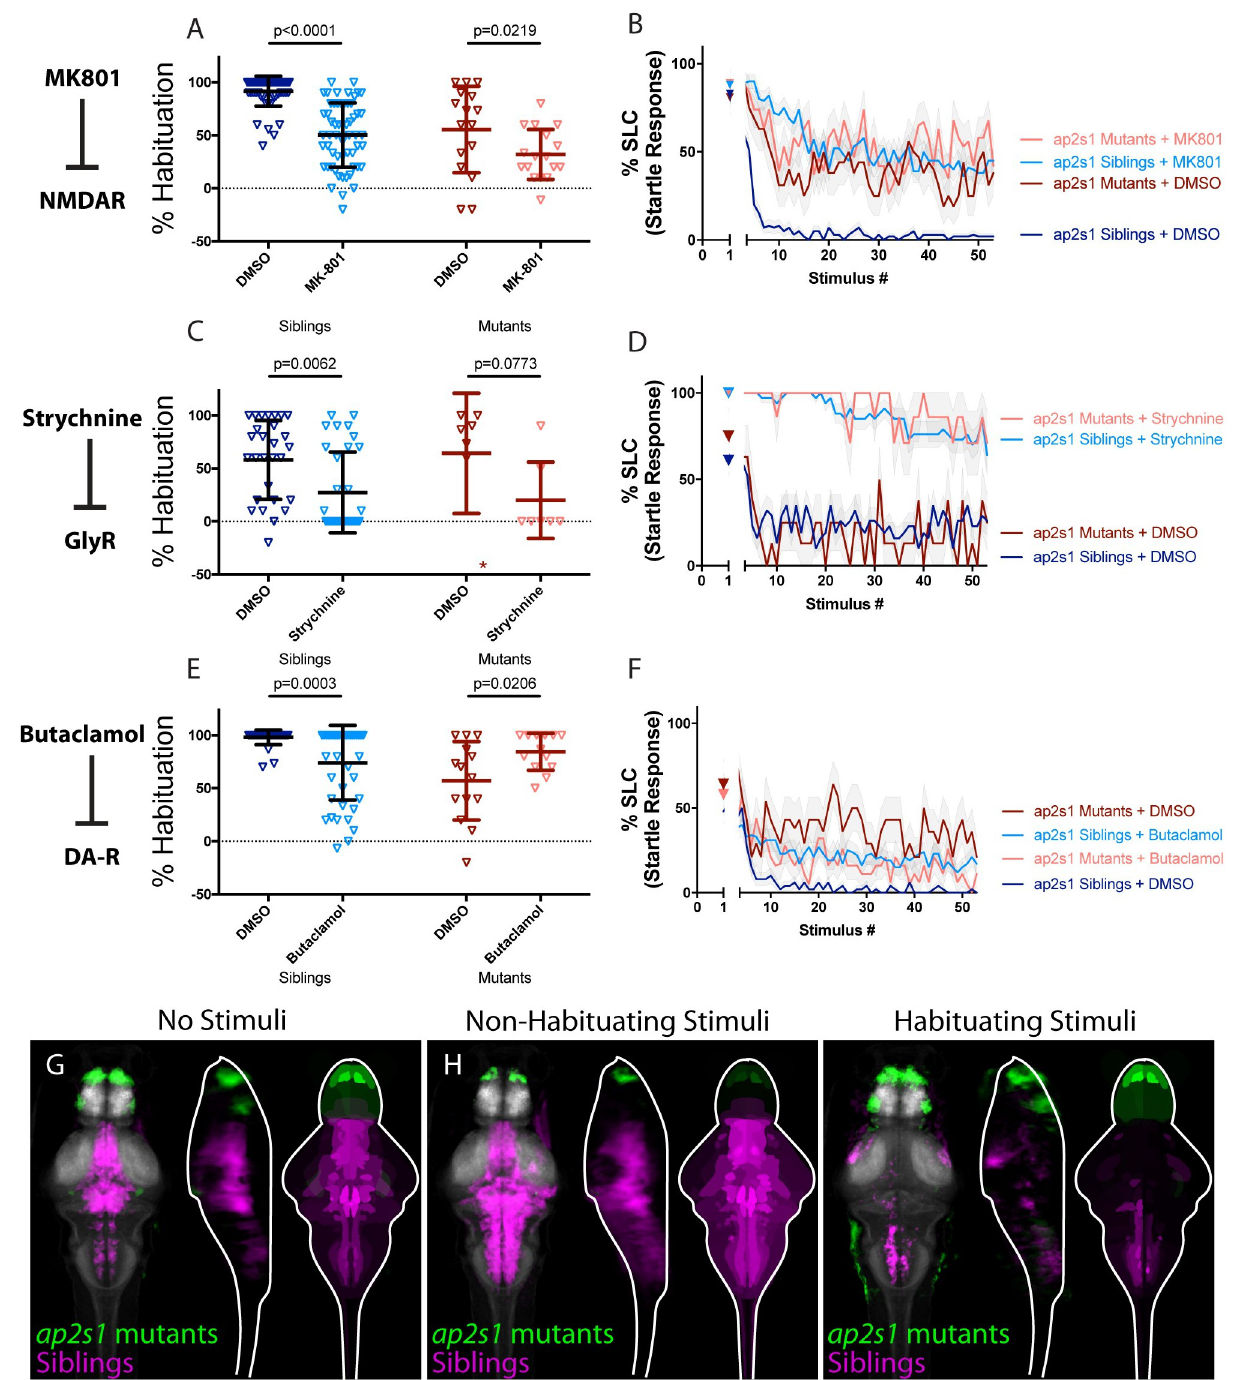
Fig 6. AP2S1 promotes habituation by limiting endogenous dopamine signaling. (A-B) MK-801 significantly enhances habituation learning deficits observed in ap2s1 mutant larvae, indicating that NMDA signaling and ap2s1 may act within parallel molecular or circuit pathways to regulate habituation (p < 0.0001, n = 54 DMSO Siblings, n = 58 MK-801 siblings; p = 0.0219, n = 16 DMSO mutants, n = 17 MK-801 mutants; p = 0.0875 indicates non- significant interaction between drug treatment and genotype). (C-D) Strychnine trends toward enhancing habituation learning deficits observed in ap2s1 mutant larvae (p = 0.0062, n = 29 DMSO siblings, n = 33 Strychnine siblings; p = 0.0773, n = 7 DMSO mutants, n = 7 Strychnine mutants; p = 0.5651 indicates non-significant interaction between drug treatment and genotype). Inspection of learning curves in (D) shows dramatic differences between vehicle and drug-treated larvae, indicating that glycine signaling and ap2s1 act within parallel molecular or circuit pathways to regulate habituation learning. * indicates a mutant+DMSO individual with a % hab value below y-axis limit at -60% (E-F) While Butaclamol inhibits habituation learning in